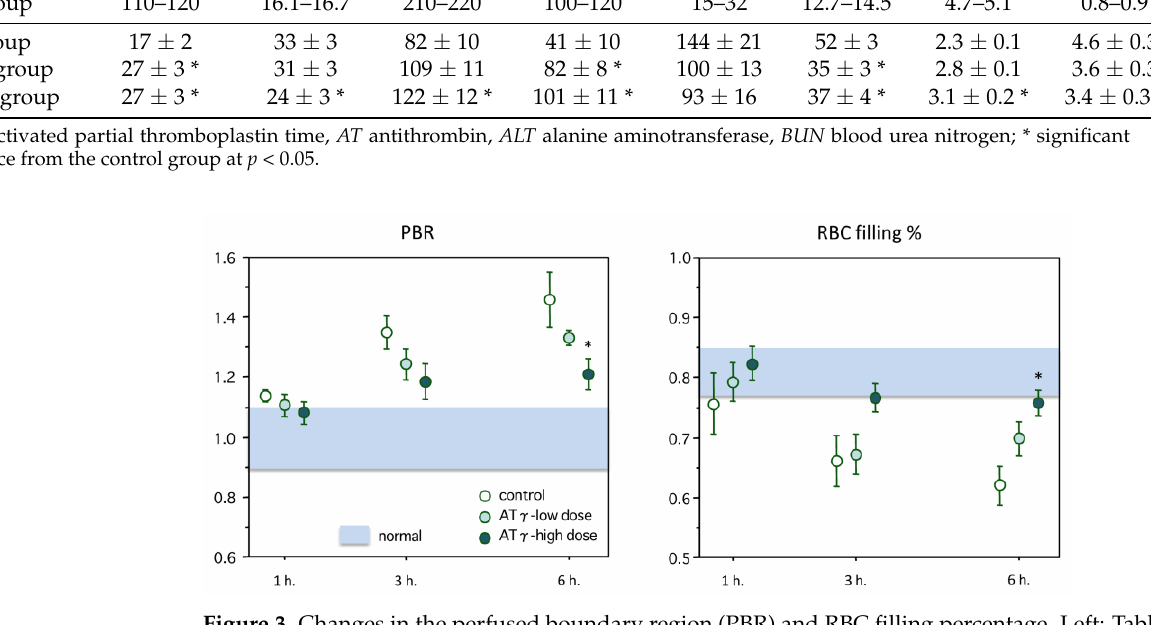
Table 1. Laboratory findings of the endotoxemic rats treated with or without antithrombin.